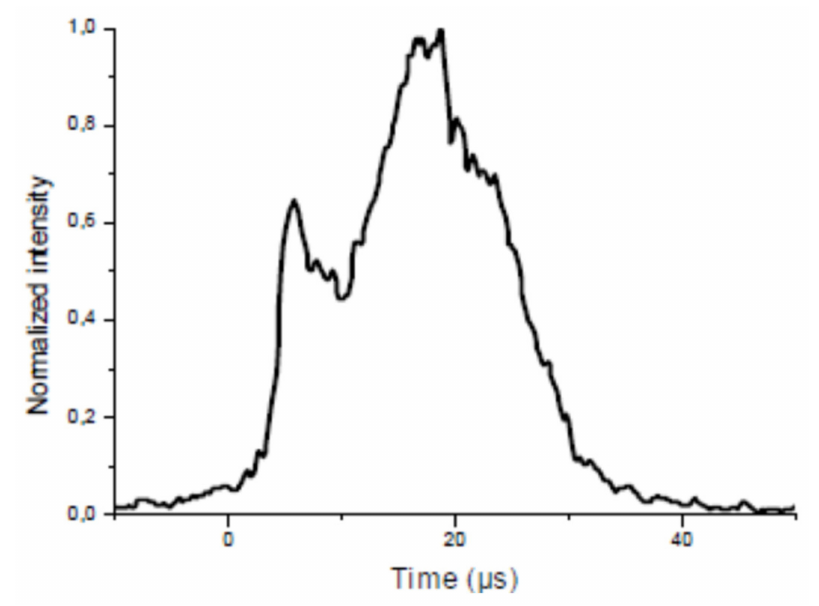
Figure 48. Time profile of CN violet ∆ v = 0 for Case 3 of Table 5 (from